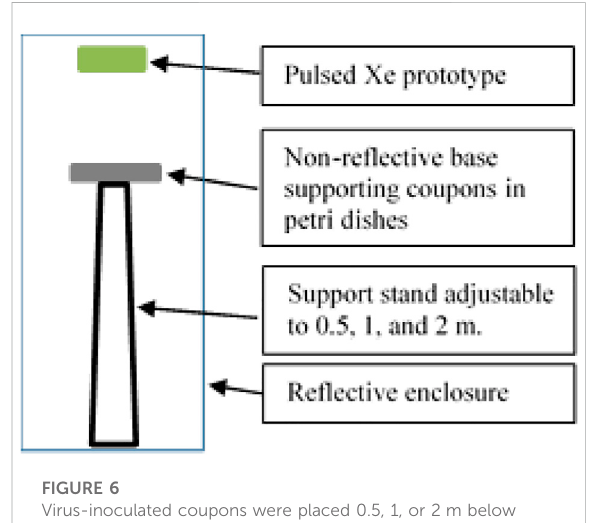
FIGURE 6 Virus-inoculated coupons were placed 0.5, 1, or 2 m below the pulsed Xe prototype.